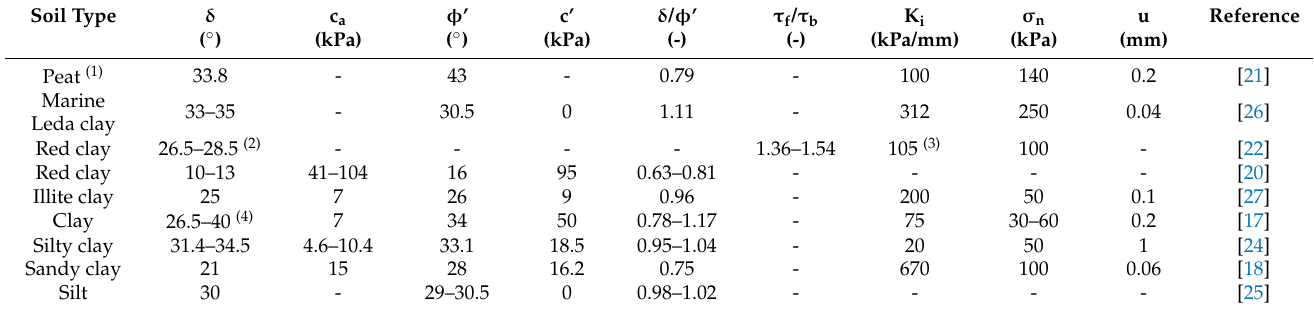
Table 2. Rough concrete interface testing